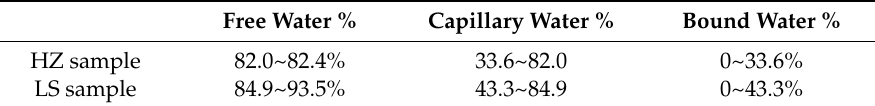
Figure 2. Water distribution of dried base in samples. Table 2. Water distribution of sludge in